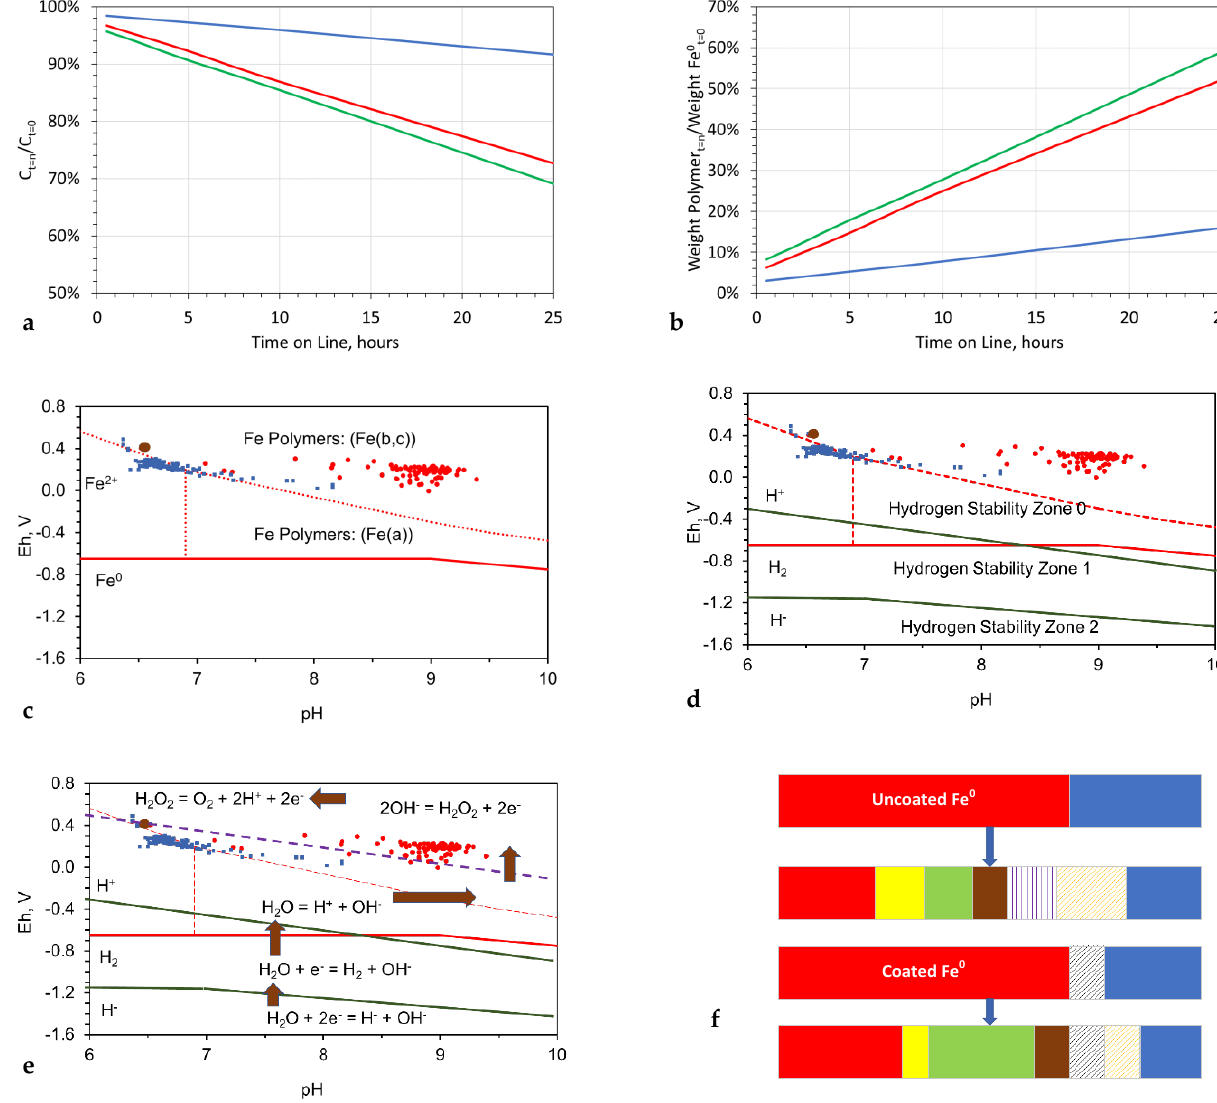
Figure 3. Indicative rates of polymer (rust) formation from uncoated Fe 0 placed in water. ( a ) C t = n / C t= 0 versus time; ( b ) Weight of polymer produced/weight of Fe 0 at time t = 0, versus time. Blue line = 1st quartile; red line = median expectation; green line = 3rd quartile.; ( c ) Pourbaix Diagram for Fe: Red dots = Product water Reactor 1; Blue dots = Product water Reactor 2; Brown dot = feed water; ( d ) Pourbaix Diagram for Fe + Hydrogen; ( e ) Pourbaix diagram for Fe, Hydrogen, OH - , H 2 O 2 and O 2 . Brown arrows indicate reaction direction in the presence of Fe 0 . ( f ) Corrosion of iron: Red = Fe 0 ; Yellow = Fe 2+ , Fe(OH) + , Fe(OH) 2 ; Green = green rust; Brown = Fe(OH) 2+ , Fe(OH) 2+ , Fe(OH) 3 ; Purple stripe = layered FeOOH, Fe(OH) 3 ; Orange Diagonal Stripe = Adsorbed oxyhydroxides; Black Diagonal Stripe = Coating.